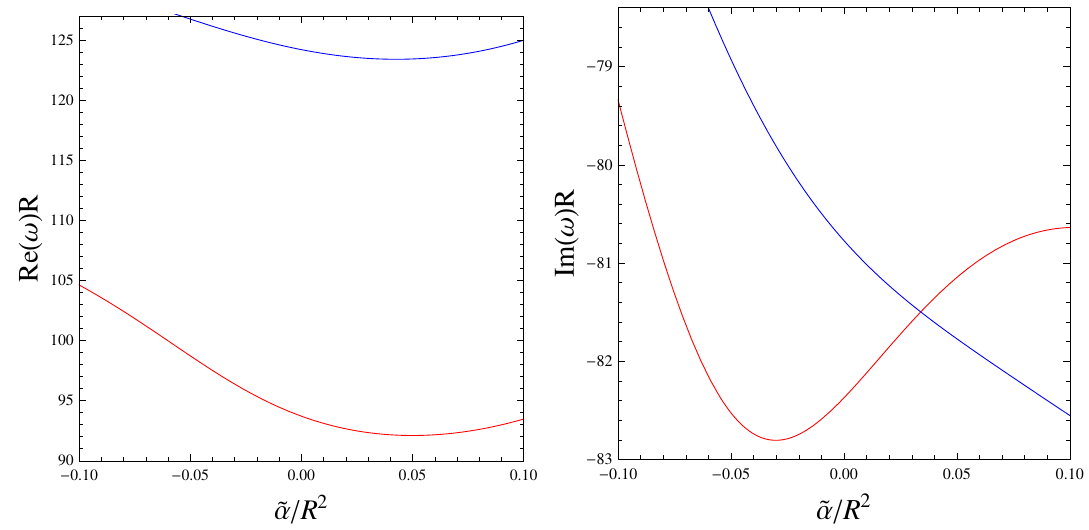
Figure 6 . Real (left panel) and imaginary (right panel) parts of ! : D = 5 (red) and D = 6 (blue), r H =R = 30, tensor channel, as a function of (cid:11) for ‘ = 2. (cid:11) ! 0. Tensor perturbative modes do not lay on the linear (cid:12)t, as can be seen from (cid:12)gure